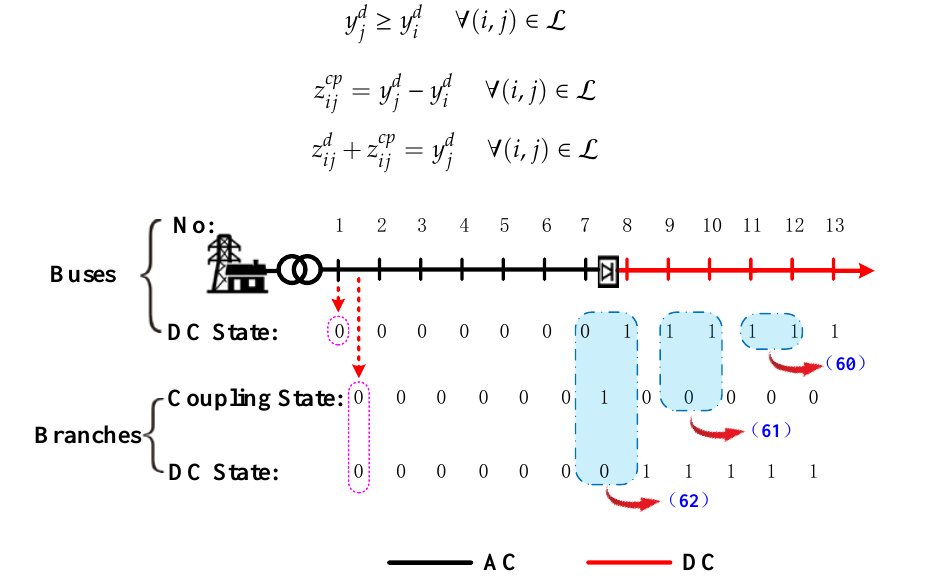
Figure 3. Illustration of the continuity of the DC feeders.